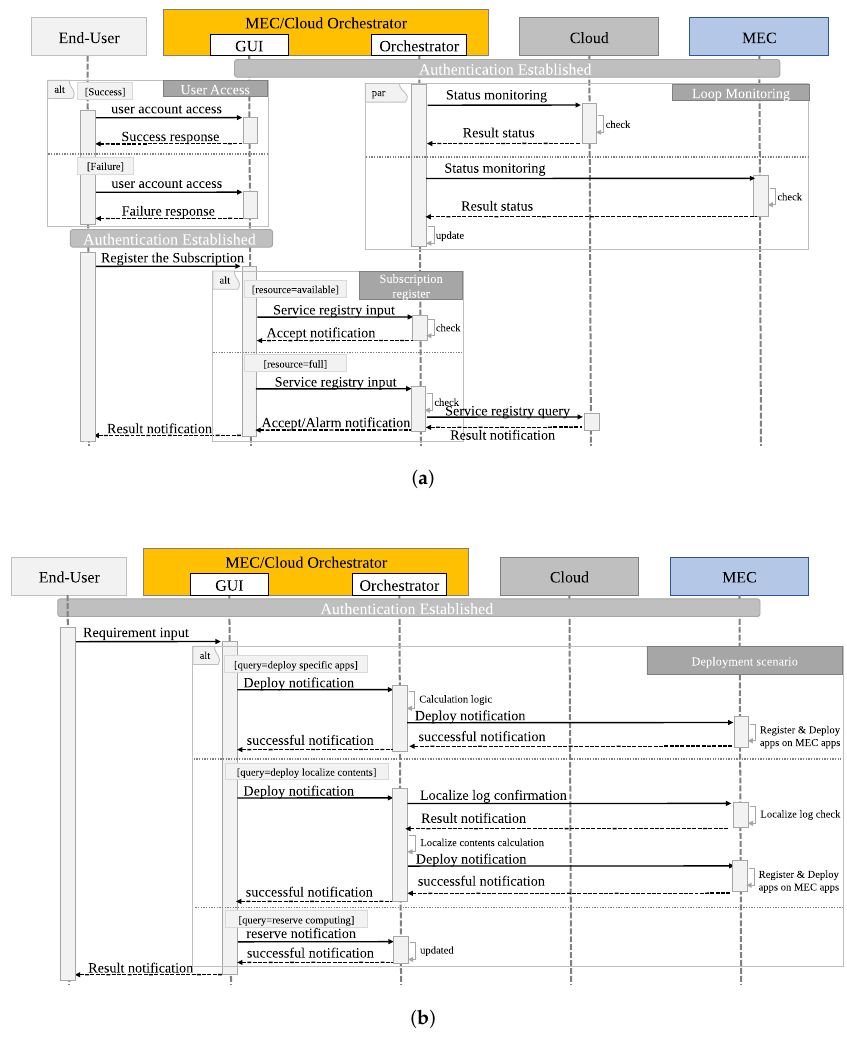
Figure 9. Sequence of MEC/Cloud Orchestrator of distributed type: ( a ) subscription registration process and ( b ) deployment